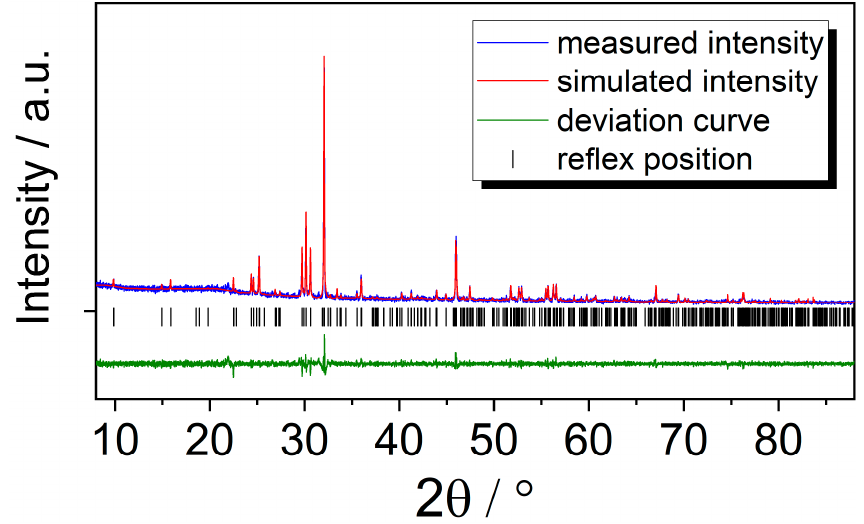
Figure 7. Le Bail profile matching of GdSb 2 O 4 Br showing the measured pattern (blue), the simulated pattern (red), the deviation plot (green), and the reflex positions (black).